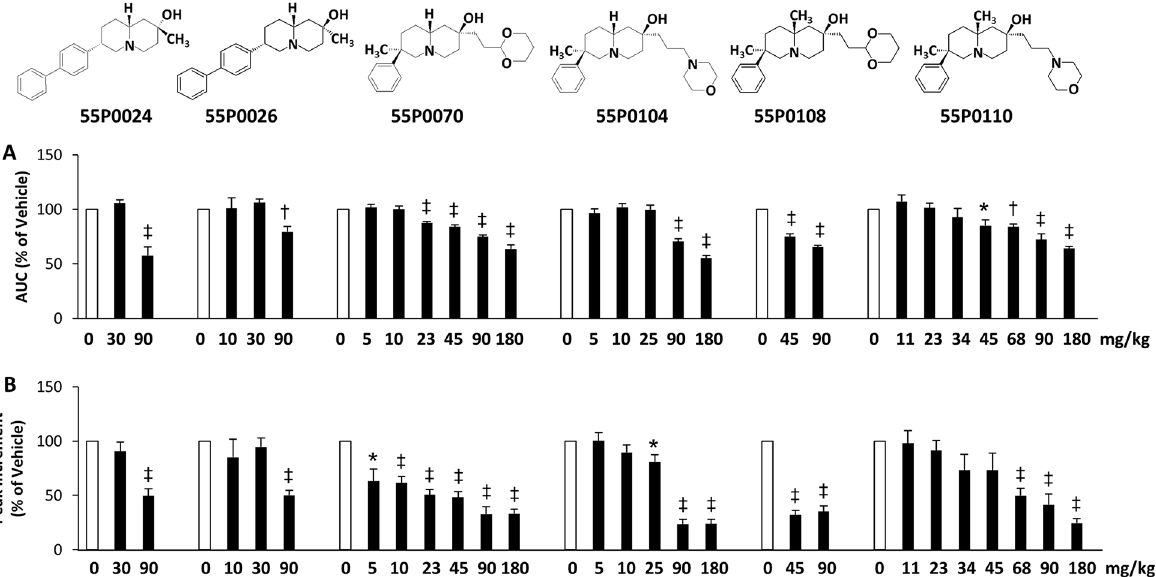
Fig 2. Novel compounds that dose-dependently improve glucose tolerance in mice. The indicated doses of novel compounds (codes and chemical structures shown above the bar graphs) were orally administered to male C57BL/6J mice 45 min before a standard oral glucose tolerance test was started (3 g/kg). Effects on the total area under the glucose curve (AUC; A ), and on the peak increment in blood glucose 30 min after glucose administration ( B ) are given as % of mean values of the corresponding vehicle group. Means ± SEM; n = 6 – 16 each; * p < 0.05; † p < 0.01; ‡ p < 0.001 vs. vehicle (= 100%; open bars).